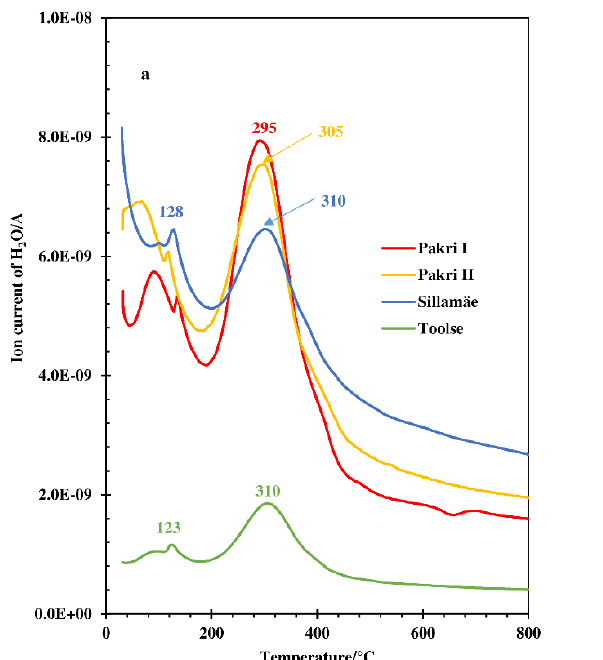
Heating up to 1200 °C, the total mass loss for Toolse, Pakri II, Sillamäe, and Pakri I GA samples was 19.1%, 26.7%, 27.0%, and 29.4%, respectively (Figure 2). Figure 2. Thermoanalytical curves (TG, DTG, DTA) of GA samples. Figure 2. Thermoanalytical curves (TG, DTG, DTA) of GA samples.